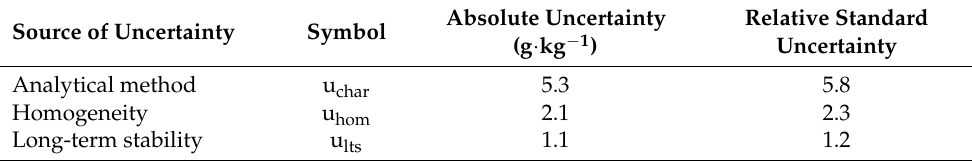
Table 6. Certified value uncertainty